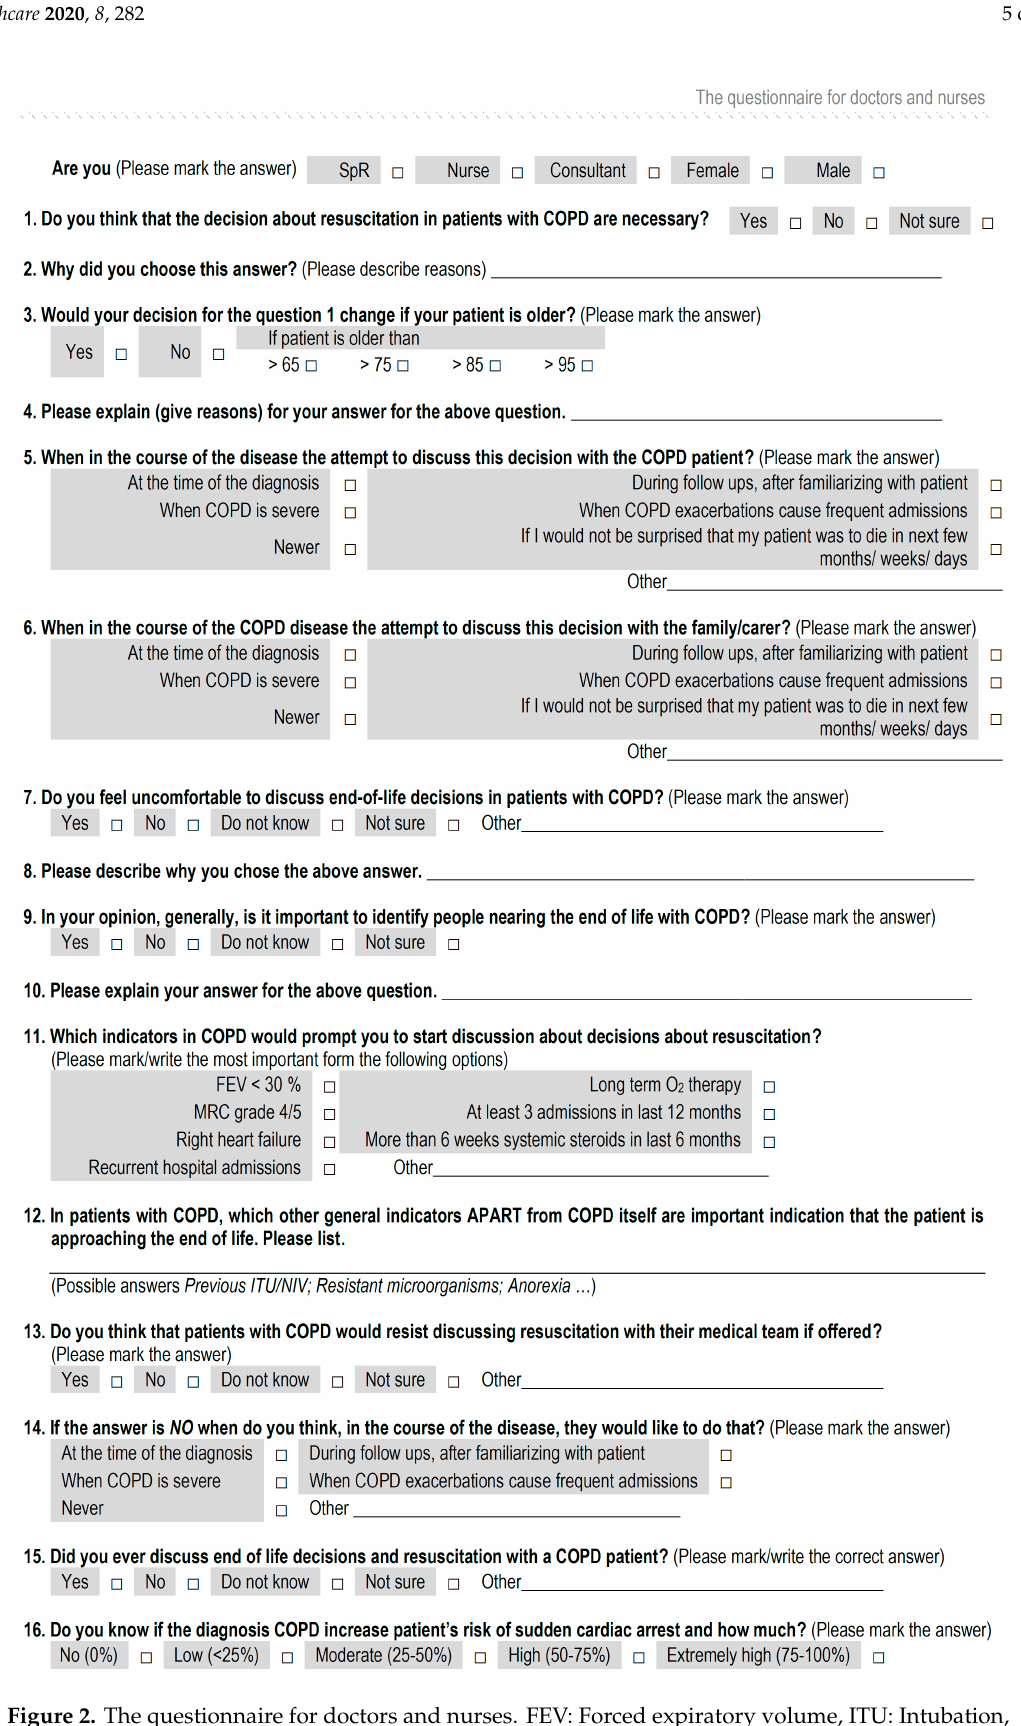
Figure 2. The questionnaire for doctors and nurses. FEV: Forced expiratory volume, ITU: Intubation, MRC: Medical Research Council, NIV: Non-Invasive Ventilation, SpR: Specialist